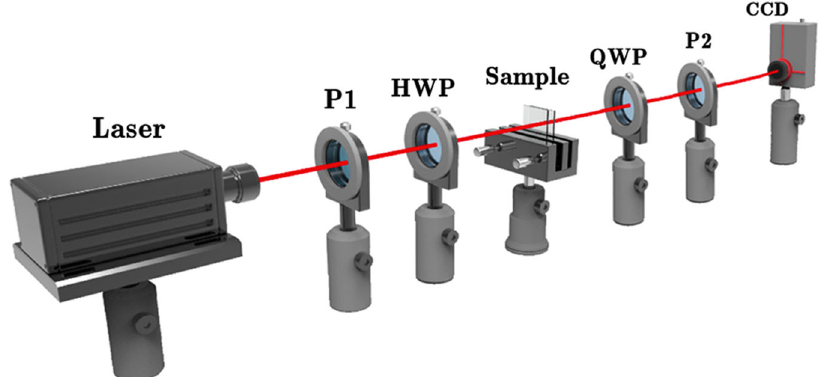
Fig. 2 Experimental set-up for PSHE measurement. A continuous-wave (CW) pump laser (671 nm) passes through the polarizer (P1) and becomes linearly polarized light. The half-wave plate (HWP) is used for modulating the polarization direction. Spin – orbit interaction processes in the LC twisting samples result in the PSHE phenomena. The pseudospin is measured with a combination of a quarter-wave plate (QWP) and a polarizer (P2). The output patterns are detected by a CCD